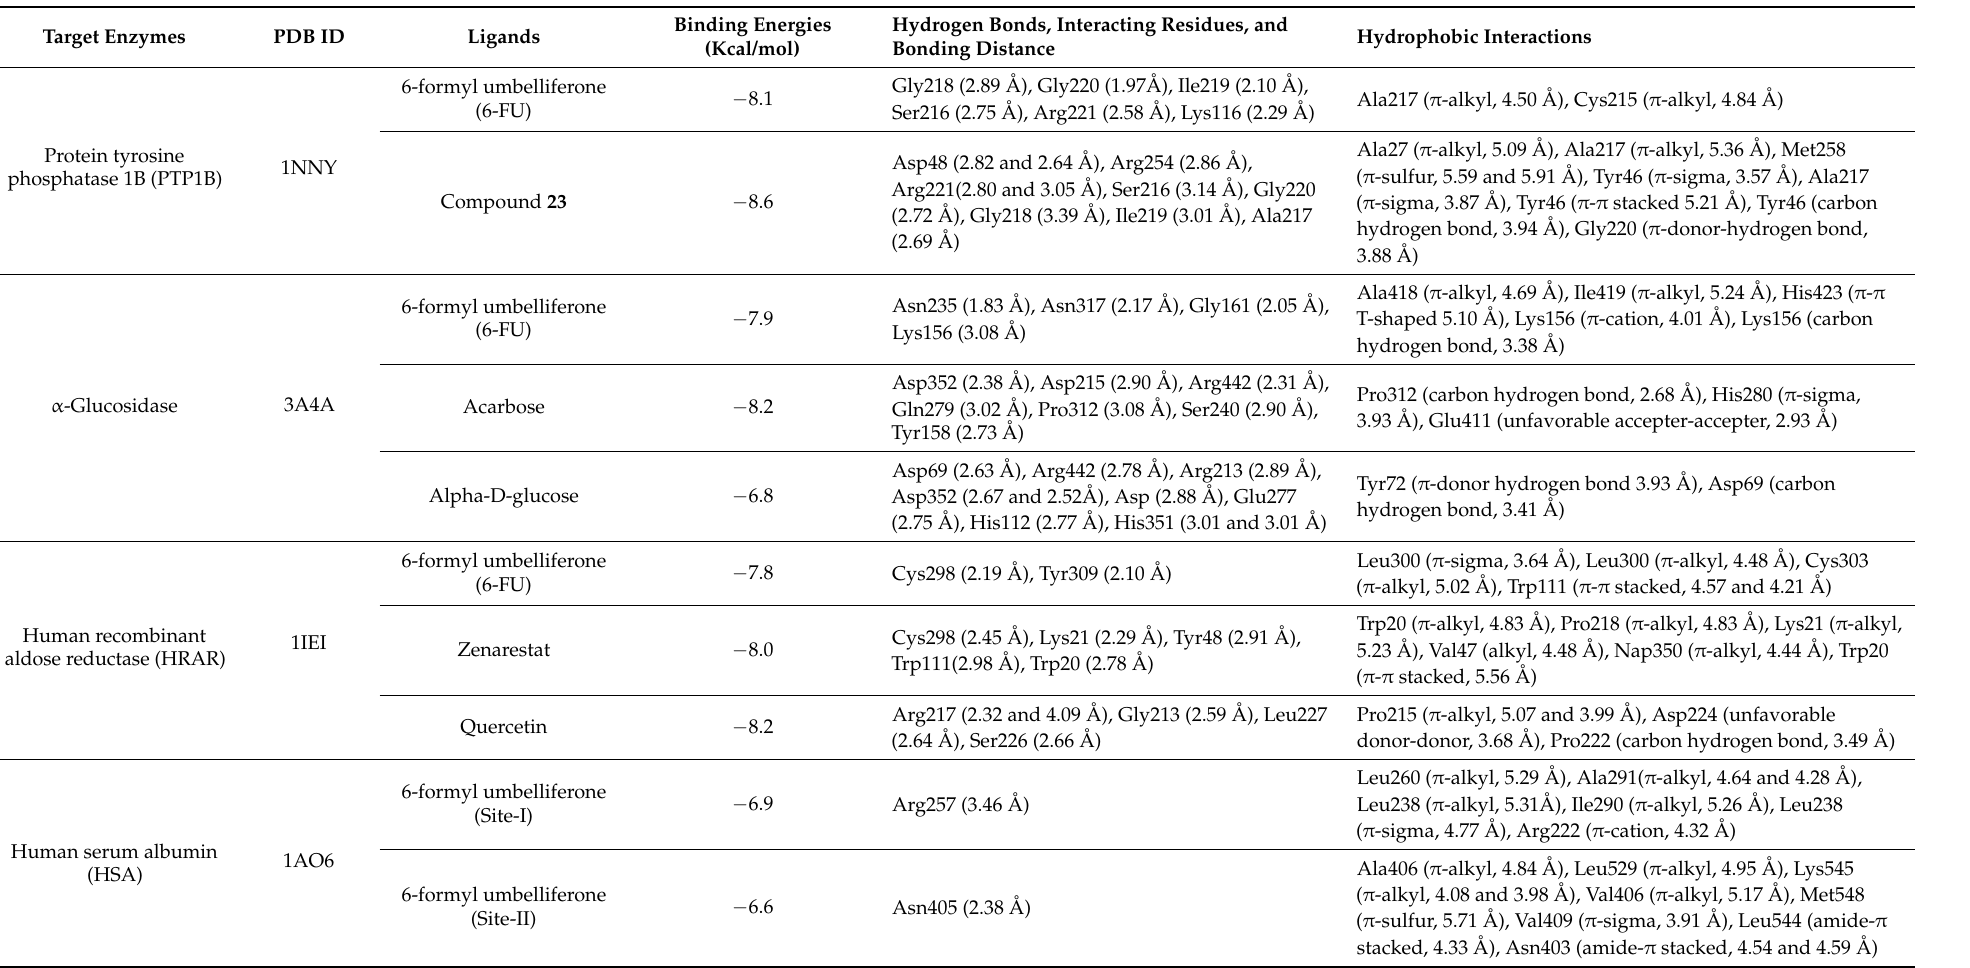
Table 2. Binding energies and binding interactions of 6-FU, cognate ligands, and positive controls in protein tyrosine phosphatase 1B (PTP1B), α -glucosidase, human recombinant aldose reductase (HRAR), and human serum albumin (HSA) using the Autodock vina docking program and visualization by Discovery Studio